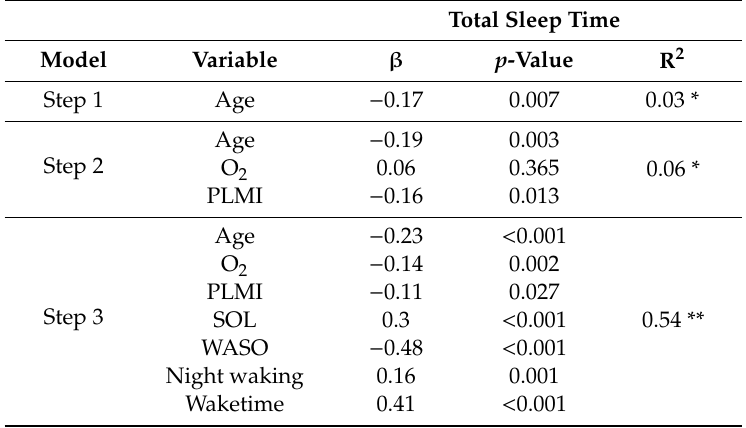
Table 6. Hierarchical multiple regression predicting total sleep time (PSG) at V1. Total Sleep